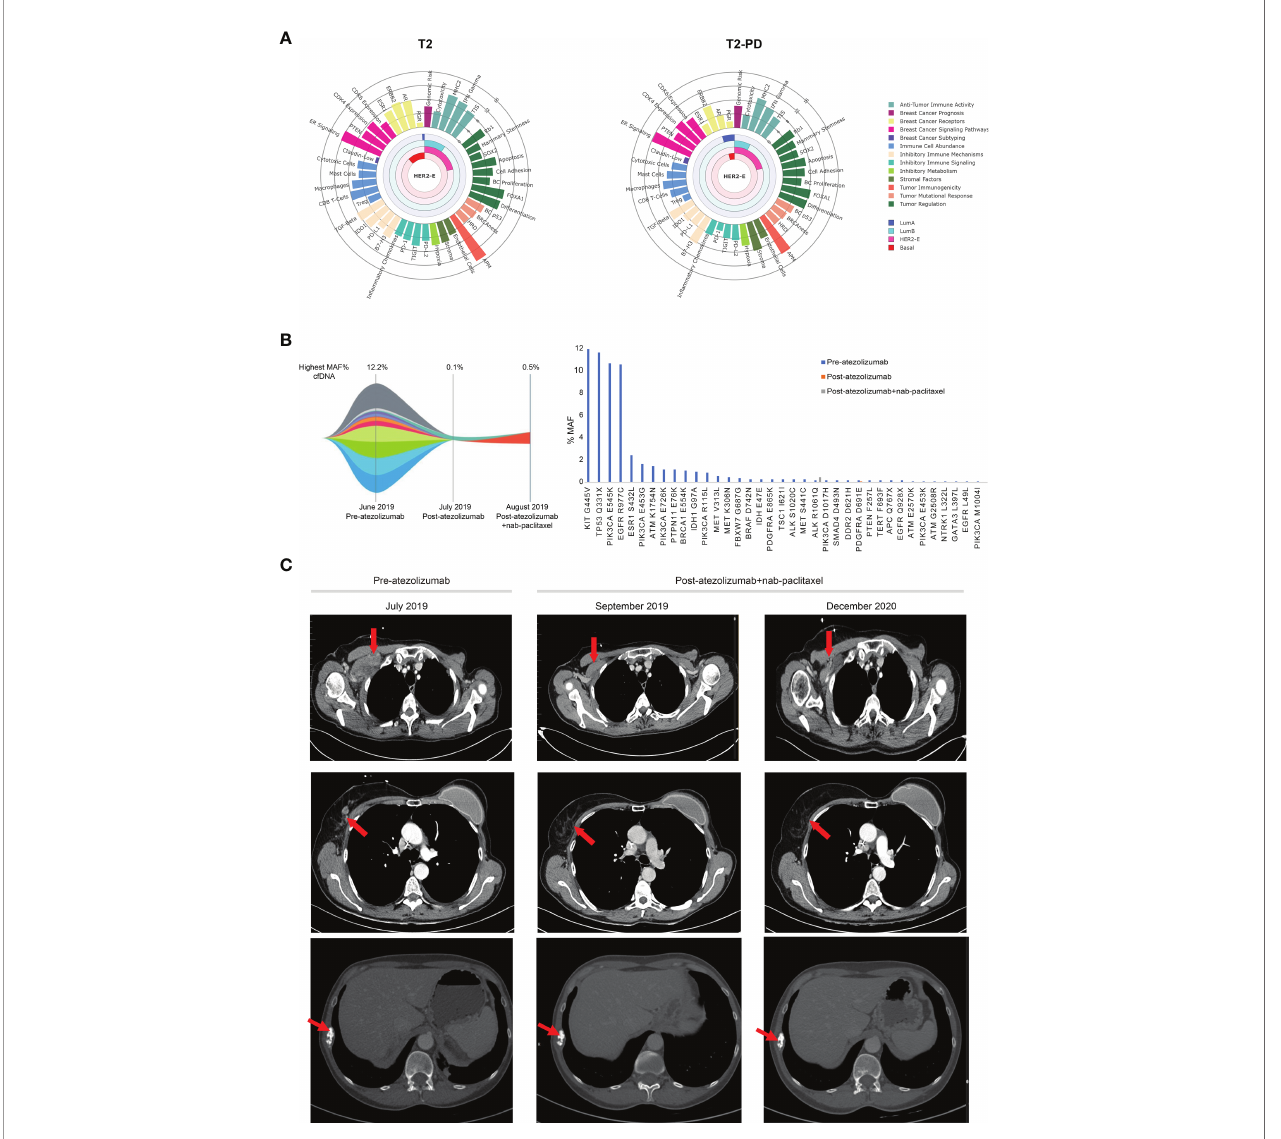
FIGURE 2 | Gene expression and molecular and clinical response to atezolizumab and nab-paclitaxel. (A) The Wheel Plots depict the relative expression of each signature for T2 and T2-PD samples determined using the Breast Cancer 360 nCounter-based gene expression panel. Signatures are grouped based on the biological process in which they belong. The Luminal A, Luminal B, HER2-enriched, and Basal-like subtype correlation scores are shown as a radial arc. Signature scores (0 – 16, low to high) are represented as radial projections. (B) Guardant360 Tumor Response Map showing the highest variant allele fraction (%) and MAF (%) assessed in ctDNA using Guardant360 results before treatment, after 3 weeks of atezolizumab monotherapy, and after combining atezolizumab and nab-paclitaxel. (C) CT scan. Red arrows indicate lesions on the soft tissue of the chest wall (top) and a mammary node (middle) and bone (bottom) during